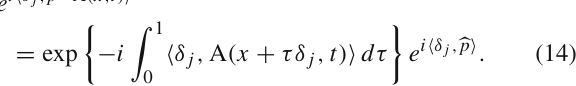
Fig. 6 Example of computation of the spectral flow. The eigen- value λ 1 ( t ) has one crossing counting as + 1; the eigenvalue λ 2 ( t ) has two crossings, one counting as − 1 and the other as + 1; as a result, the spectral flow is ( + 1 ) + ( − 1 ) + ( + 1 ) =